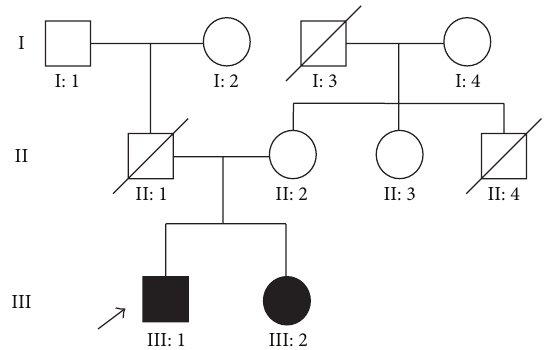
Figure 1: Pedigree of the family with RP. Solid symbols indicate affected individuals. Open symbols indicate unaffected individuals and arrow indicates the proband and slash indicates deceased